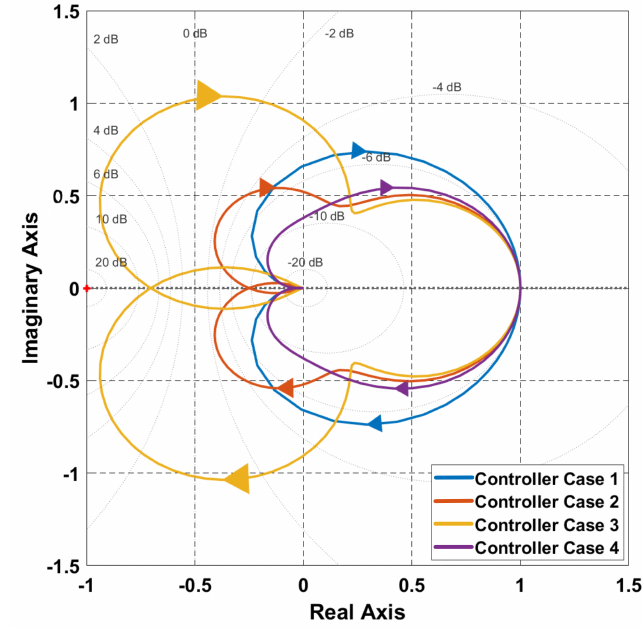
Figure 4. The Nyquist plots of the four controller cases.